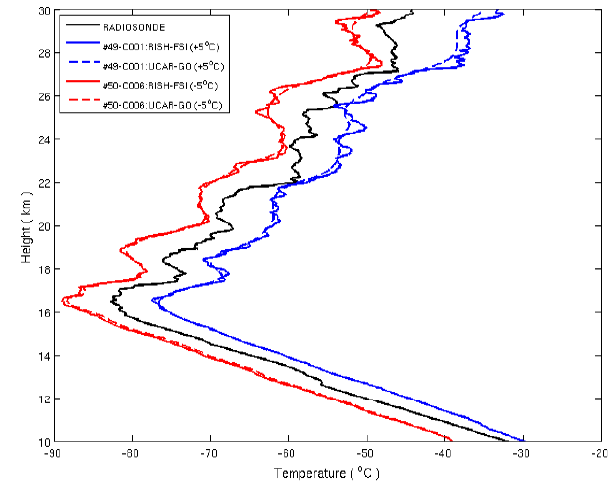
Fig. 3. Comparison of temperature profiles from the COSMIC GPS RO and radiosonde launched at Kuching (black line in the middle). The solid blue and red lines correspond to the FSI results analyzed in this study for #49 and #50, respectively, and the thin dashed lines are taken from the CDAAC database. The profiles are shifted by + 5K and − 5K for #49 and #50 relative to the radiosonde